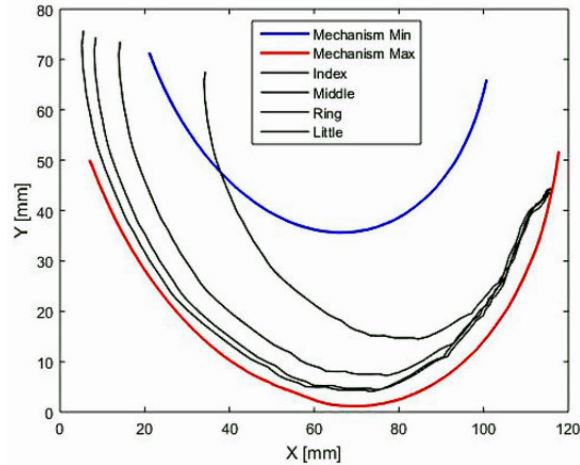
Figure 15. Workspace trajectories and index fingers.